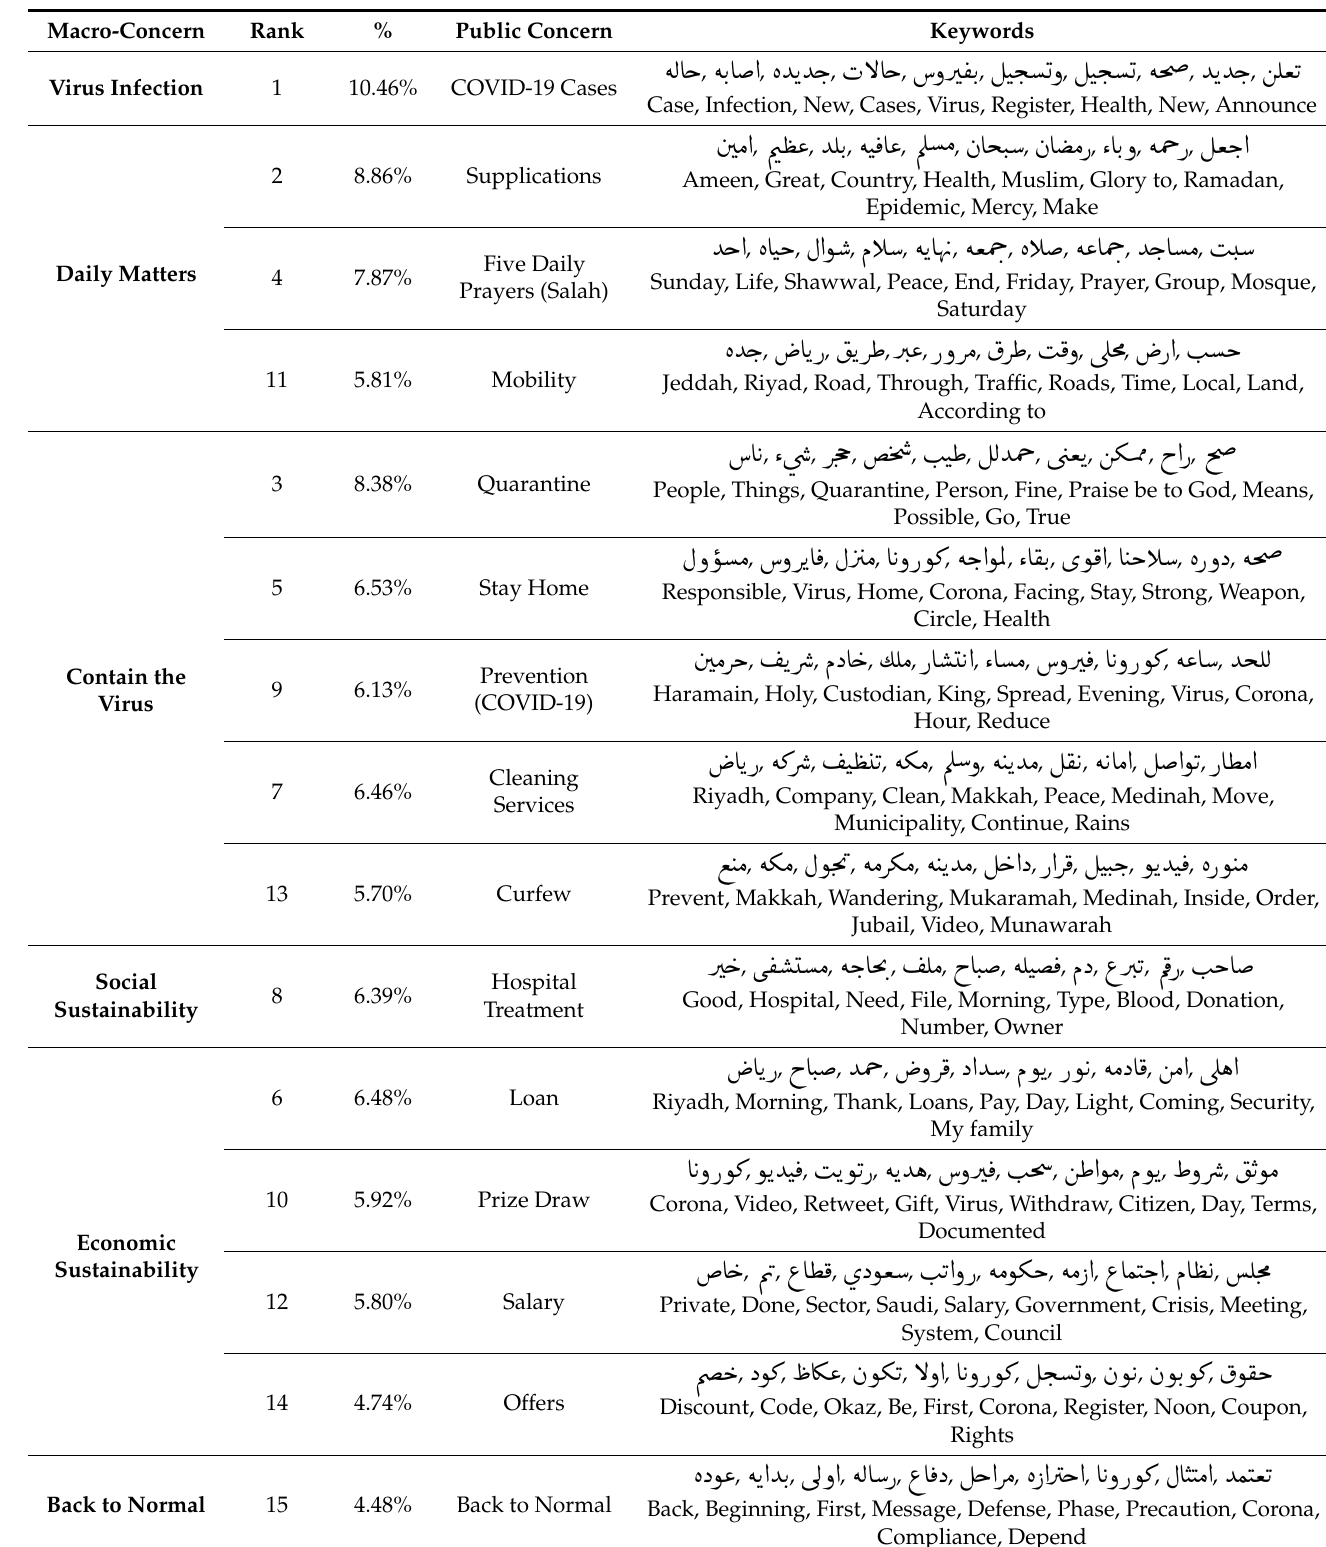
Table 1. COVID-19 pandemic: government measures and public concerns (1 February–1 June 2020).